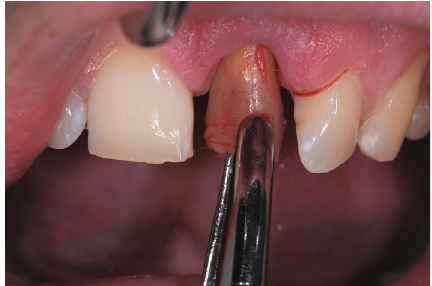
Figure 7: Minimally traumatic removal of the failing tooth using forceps with rotational movement.